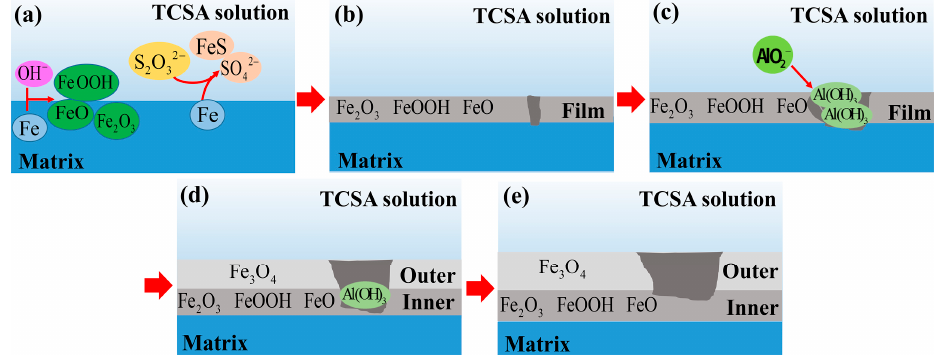
Figure 9. Schematic ( a – e ) of the corrosion product film formed on the 12Cr1MoV steel surface when immersed in the TCSA solution.